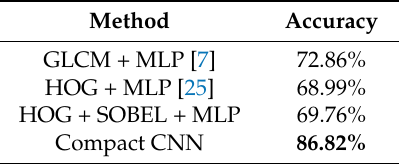
Table 4. The performance of classification results with different